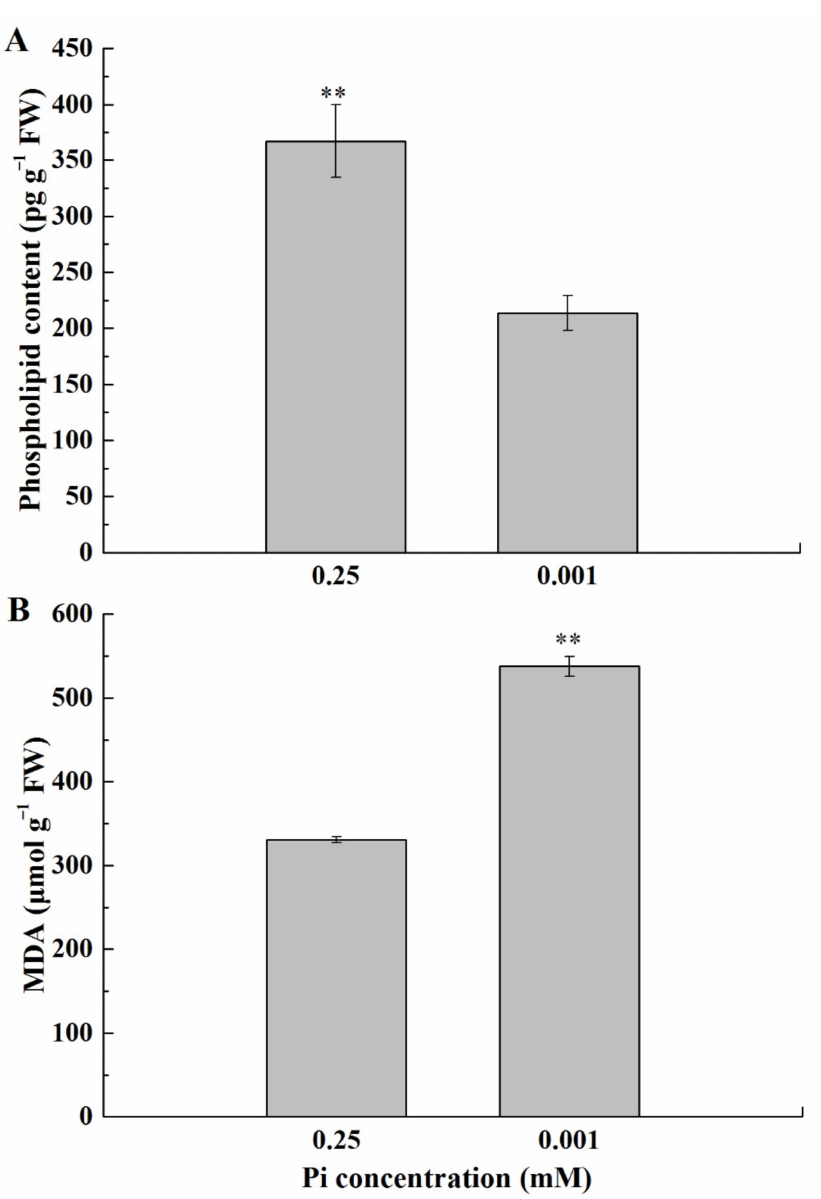
Figure 4. Phospholipid contents ( A ) and MDA contents ( B ) in the first true leaf under the different Pi treatments. The error bars indicate SD ( n = 4). The asterisks indicate the significant differences according to Tukey’s test using a one-way ANOVA (** p <